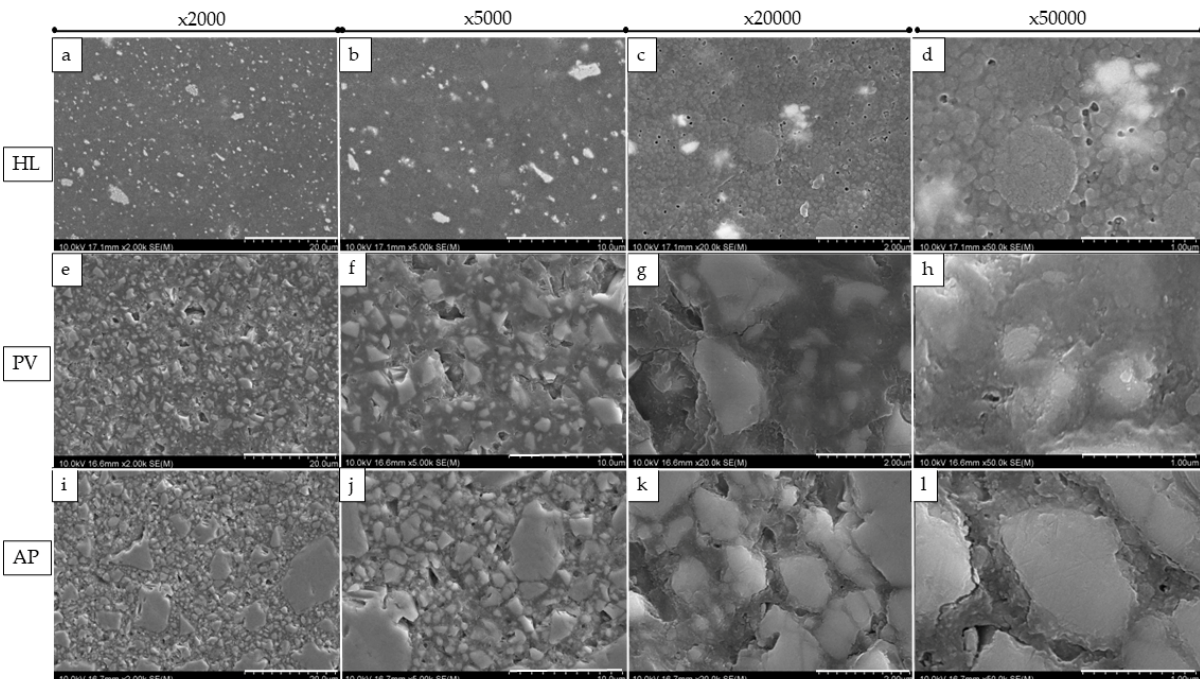
Figure 3. Representation of SEM images of the resin cement fillers. The rows from left to right pre- sent images with magnifications of ×2000, ×5000, ×20,000, and ×50,000, respectively; ( a – d ) represent HL; ( e – h ) represent PV; and ( i – l ) represent AP. The red circle represents a cluster with a regular distribution, and the yellow arrow represents nanometer-sized particles with a regular form.